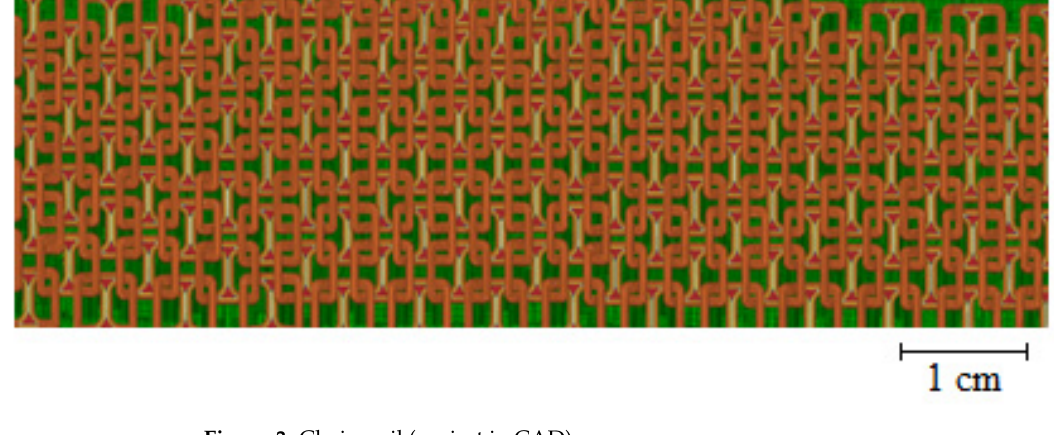
Figure 3. Chainmail (project in CAD).